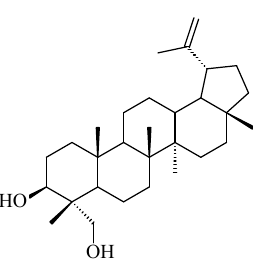
Figure 4. New lupane-type triterpene isolated from B. simaruba [33].